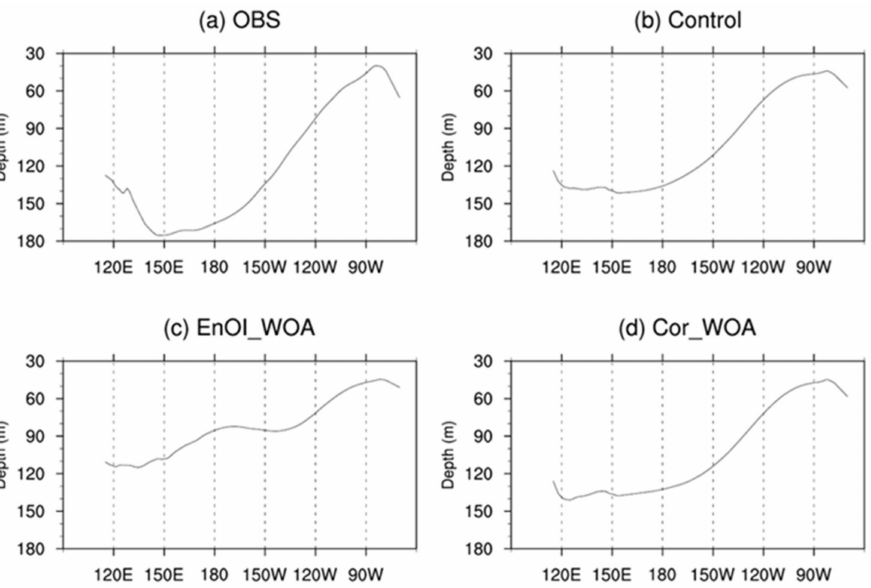
Figure 1. Long-term average depth of the tropical Pacific thermocline (units: m). ( a – d ) represent OBS, Control, EnOI_WOA, and